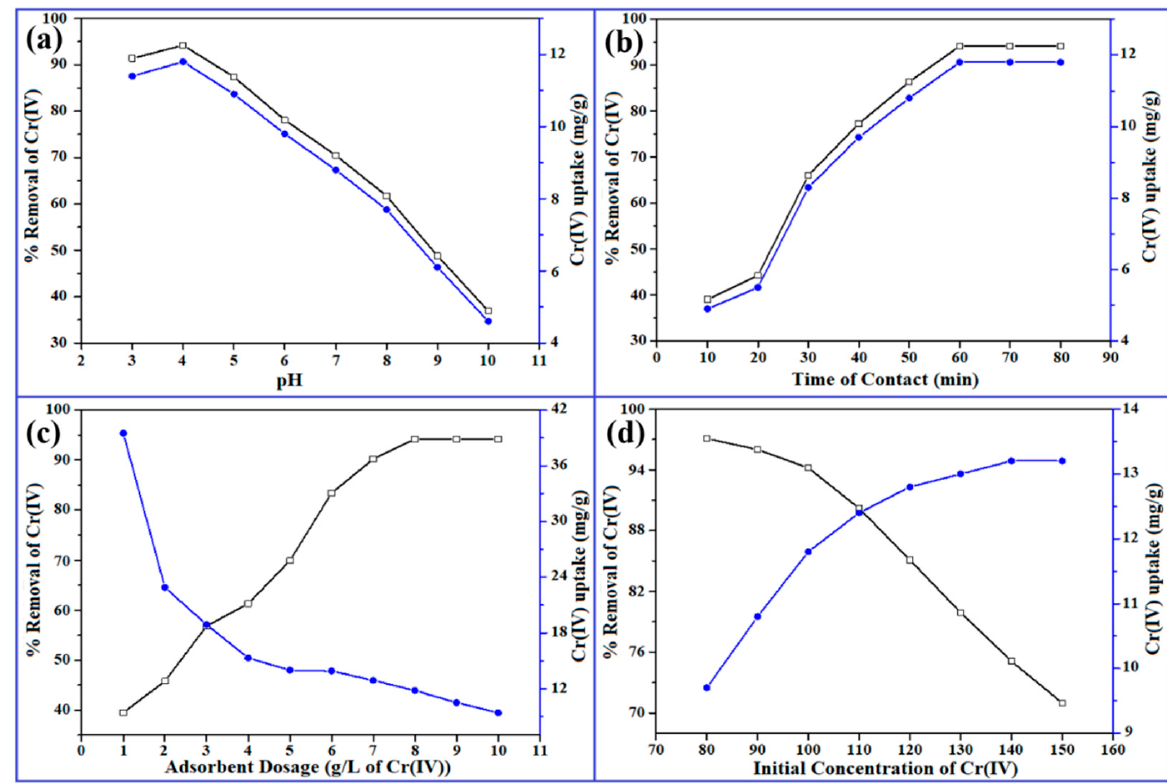
Figure 5. Parameters affecting percentage removal of Cr(VI) and Cr(VI) uptake (mg/g) using Al- GNSC, the influence of ( a ) pH, ( b ) contact time, ( c ) Al-GNSC dosage, and ( d ) initial Cr(VI) concen- tration.